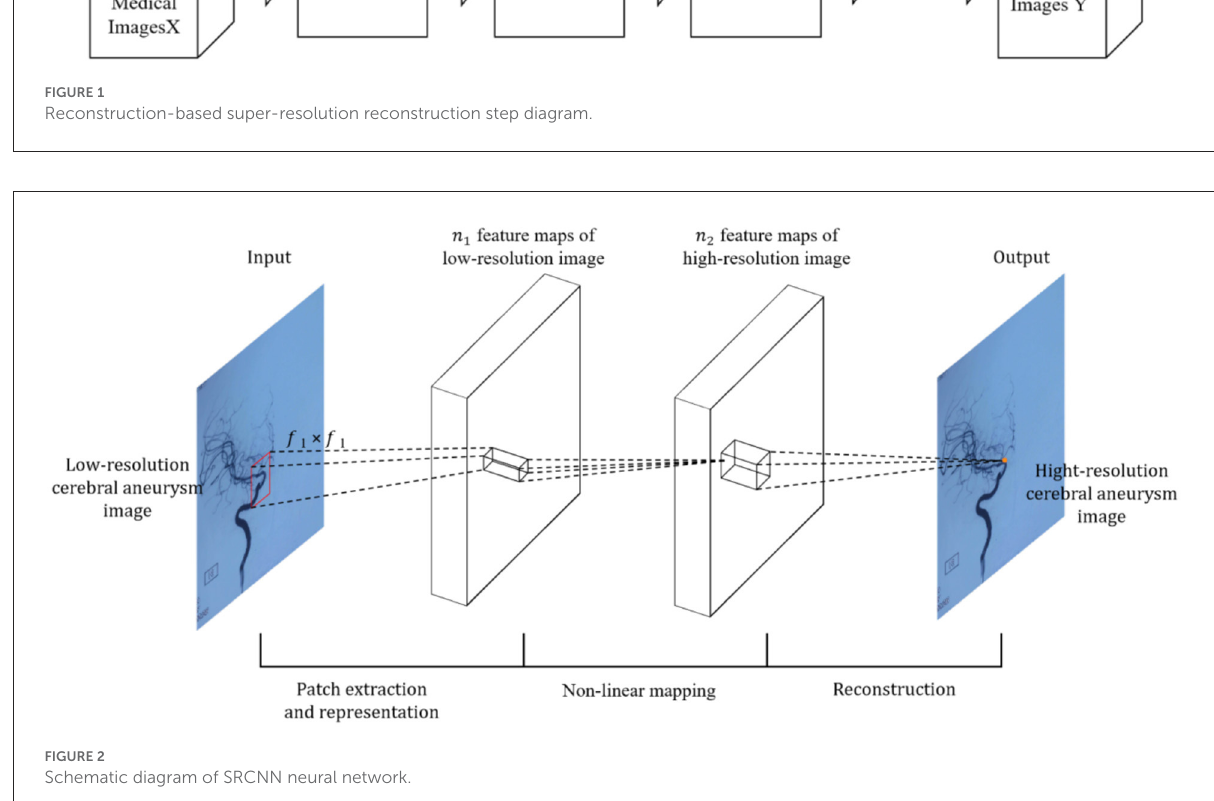
FIGURE2 Schematic diagram of SRCNN neural